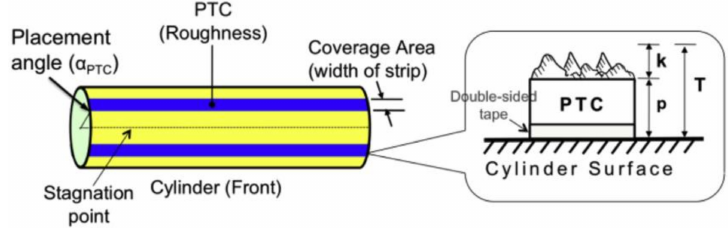
Figure 2. Configuration of the turbulence stimulation (PTC) on the cylinder